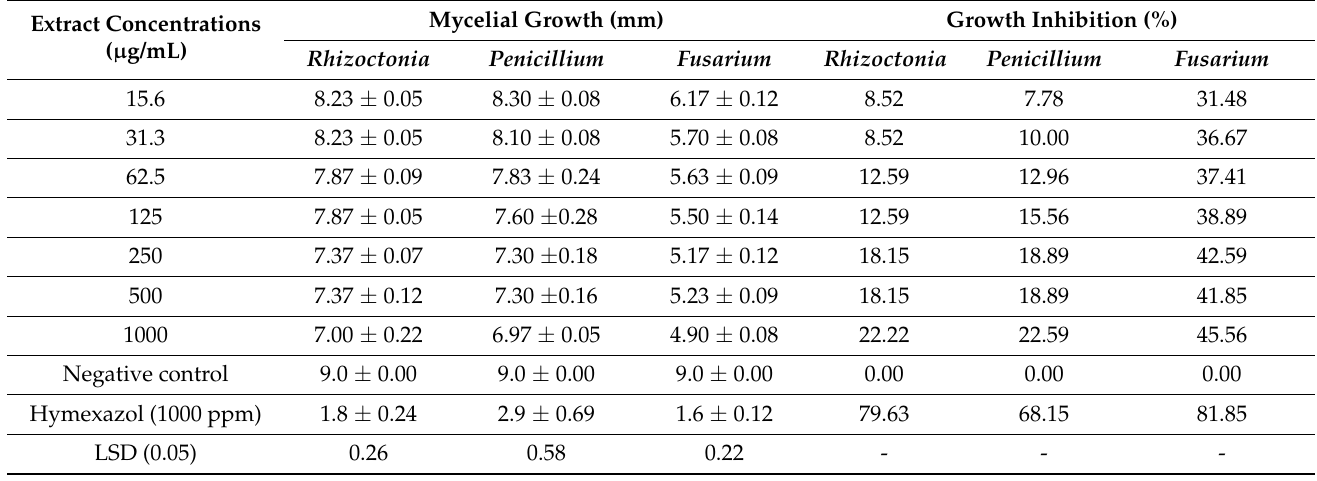
Table 5. Antifungal activities of A. vulgaris root extract against Rhizoctonia solani , Penicillium italicum and Fusarium oxysporium . Data are shown as mean ± SD, n = 3.